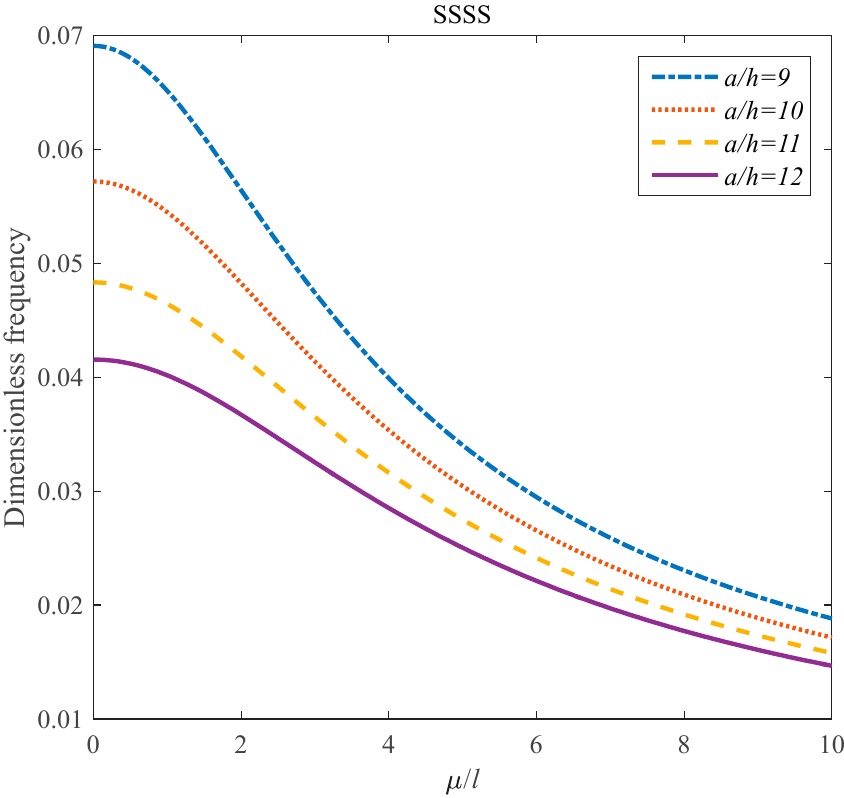
Figure 3. The influences of a / h and µ / h on the frequency for the SSSS boundary conditions with a / b = 5, l = h /5, ∆ T = 100 K , N L = 10, g GPL = 0.5% and GPL-x.